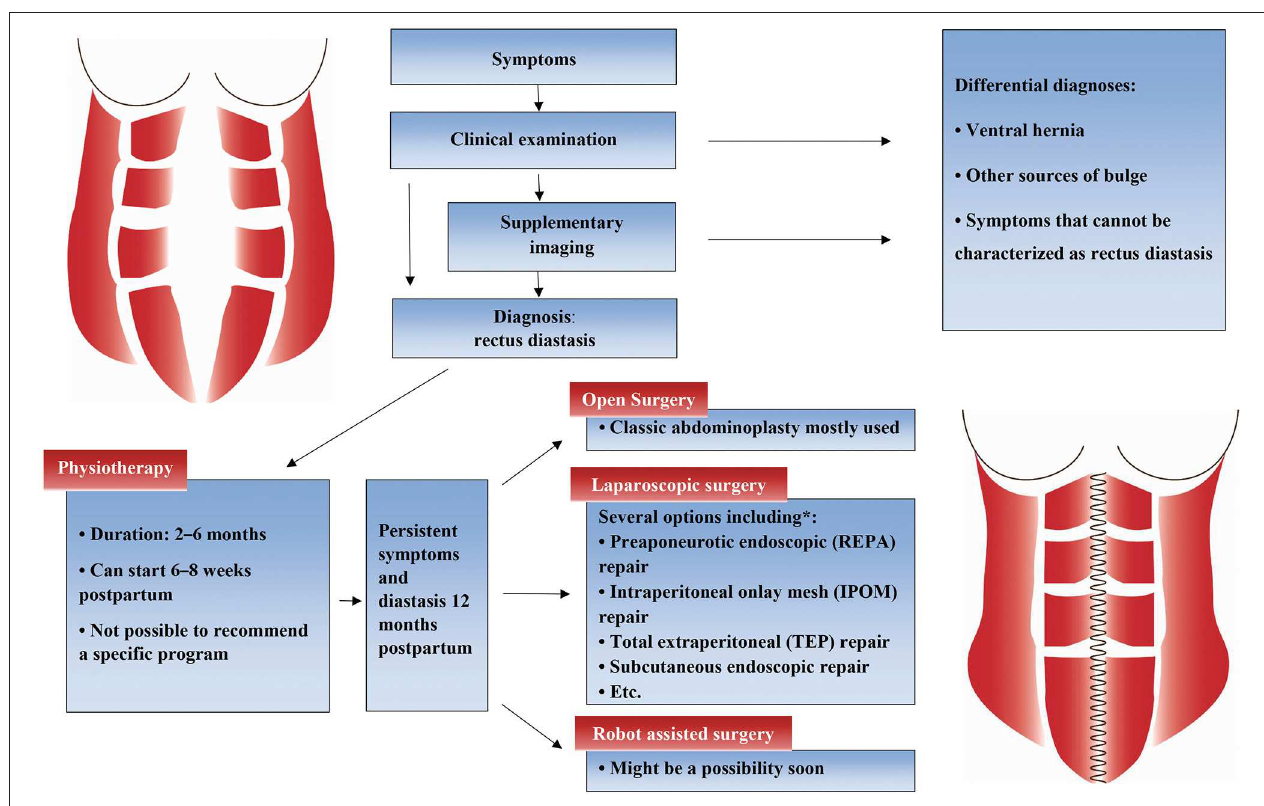
FIGURE 1 | Flowchart with suggested treatment steps. *: Laparoscopic techniques used for rectus diastasis repair: pre-aponeurotic endoscopic (REPA) repair (28), intraperitoneal onlay mesh (IPOM) repair (31), total extraperitoneal (TEP) repair, subcutaneous endoscopic repair (34, 36) or other endoscopic abdominoplasty techniques ( 29, 32,